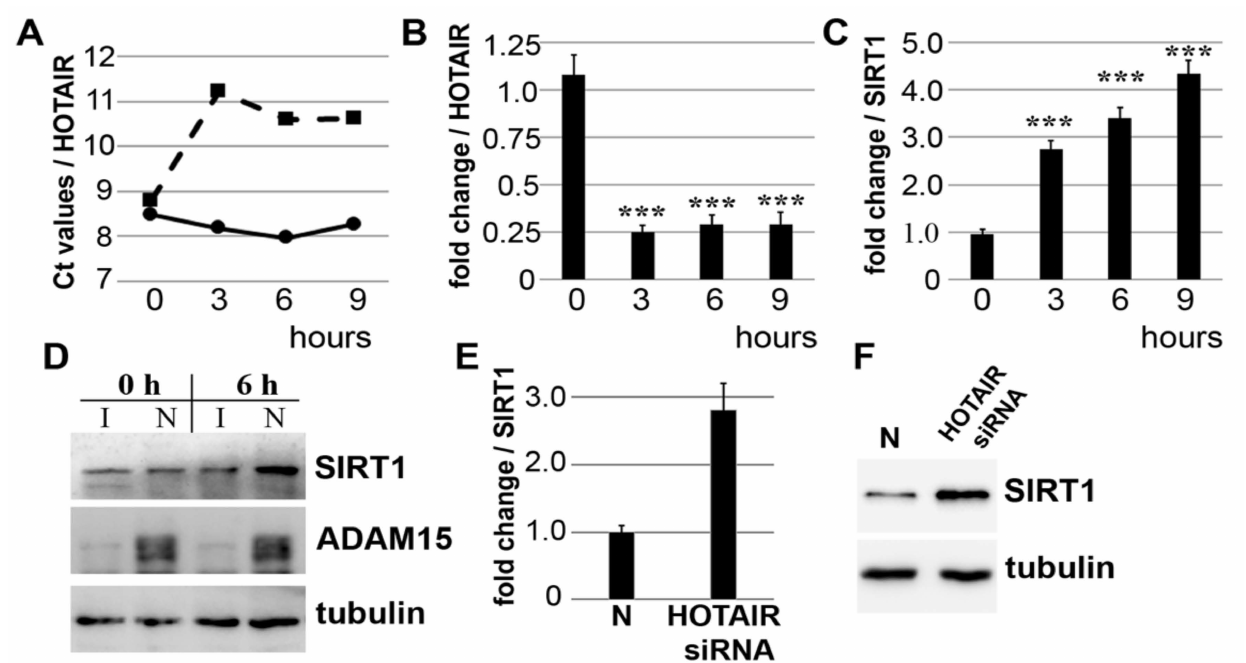
Figure 2. ADAM15-dependent downregulation of HOTAIR under mechanical strain, resulting in the upregulation of SIRT1. ( A – D ) SF with prior downregulation of ADAM15 were strained for 0–9 h, and HOTAIR and SIRT mRNA and protein expression was quantified by qPCR and immunoblotting. ( A ) GAPDH-normalized Ct values for HOTAIR from one representative donor, showing higher Ct values, i.e., reduced HOTAIR levels, in ADAM15-expressing SF (dashed line), as compared to SF treated with ADAM15 siRNA (solid line). ( B,C ) Fold change (mean ± SD from 7 donors) of HOTAIR and SIRT1 mRNA in ADAM15-expressing versus non-expressing SF. *** p < 0.0005, by Student’s t -test, when comparing stimulated versus unstimulated HOTAIR/SIRT levels. ( D ) Immunoblots from SF silenced with ADAM15 siRNA (I) and negative control siRNA (N), showing increased SIRT1 expression in ADAM15-expressing cells after 6 h strain. ( E,F ) Fold change of SIRT1 after HOTAIR downregulation in SF ( n = 6) when unexposed to mechanical strain by siRNA and negative control siRNA (N), showing increased SIRT1 mRNA ( E ) and protein levels ( F ). Tubulin served as a loading